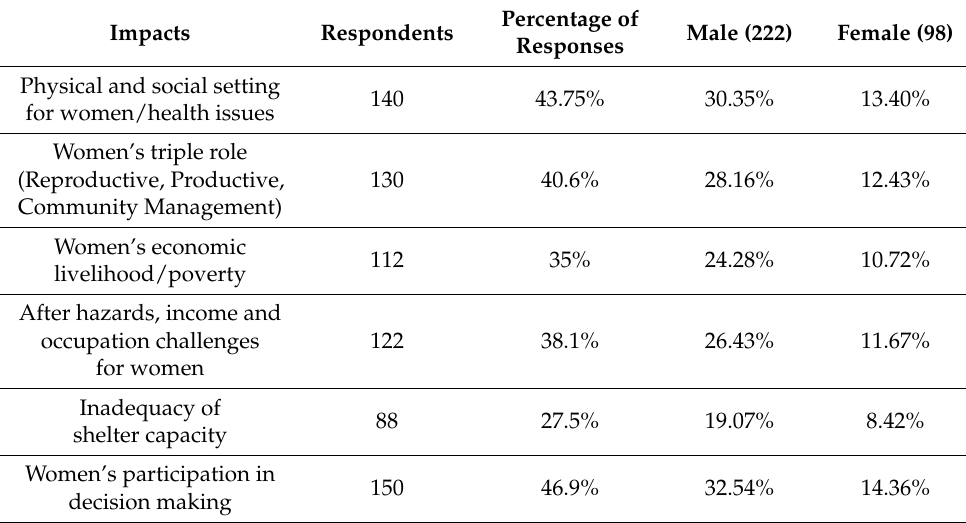
Table 5. The impacts of climate change on gender in